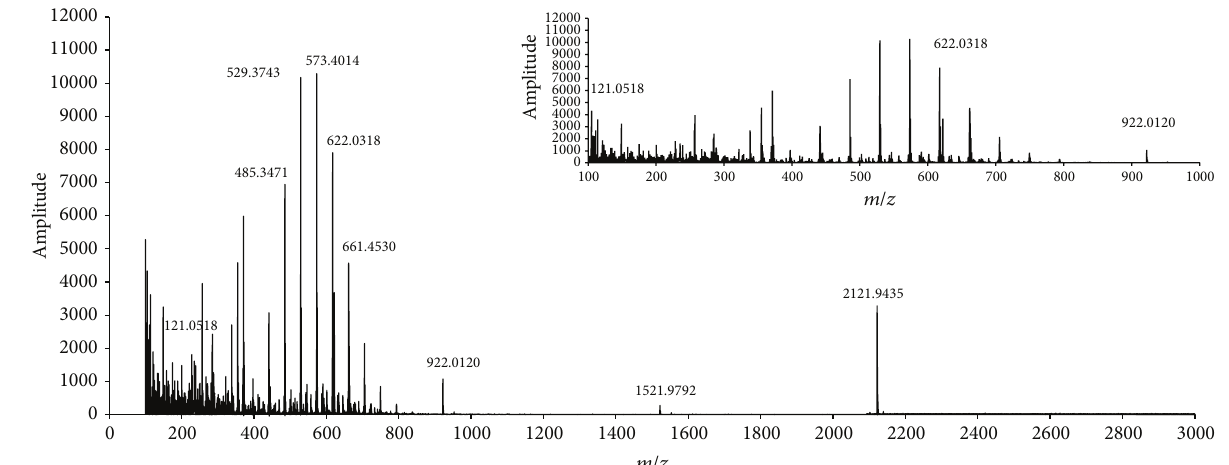
Figure 8: Mass spectrum of the DOM of size less than 0.45 𝜇 m obtained from point 3. Spectrum registered with